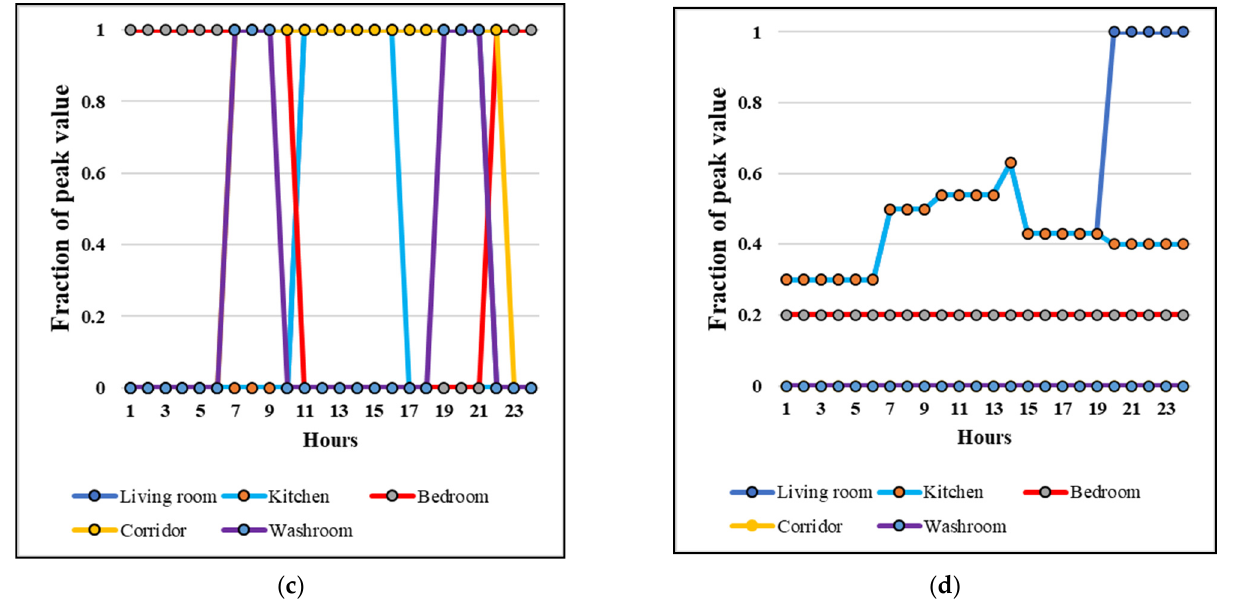
Figure 4. Weekend building schedules. ( a ) Occupancy schedule, ( b ) lighting schedule, ( c ) HVAC schedule, ( d ) equipment schedule.